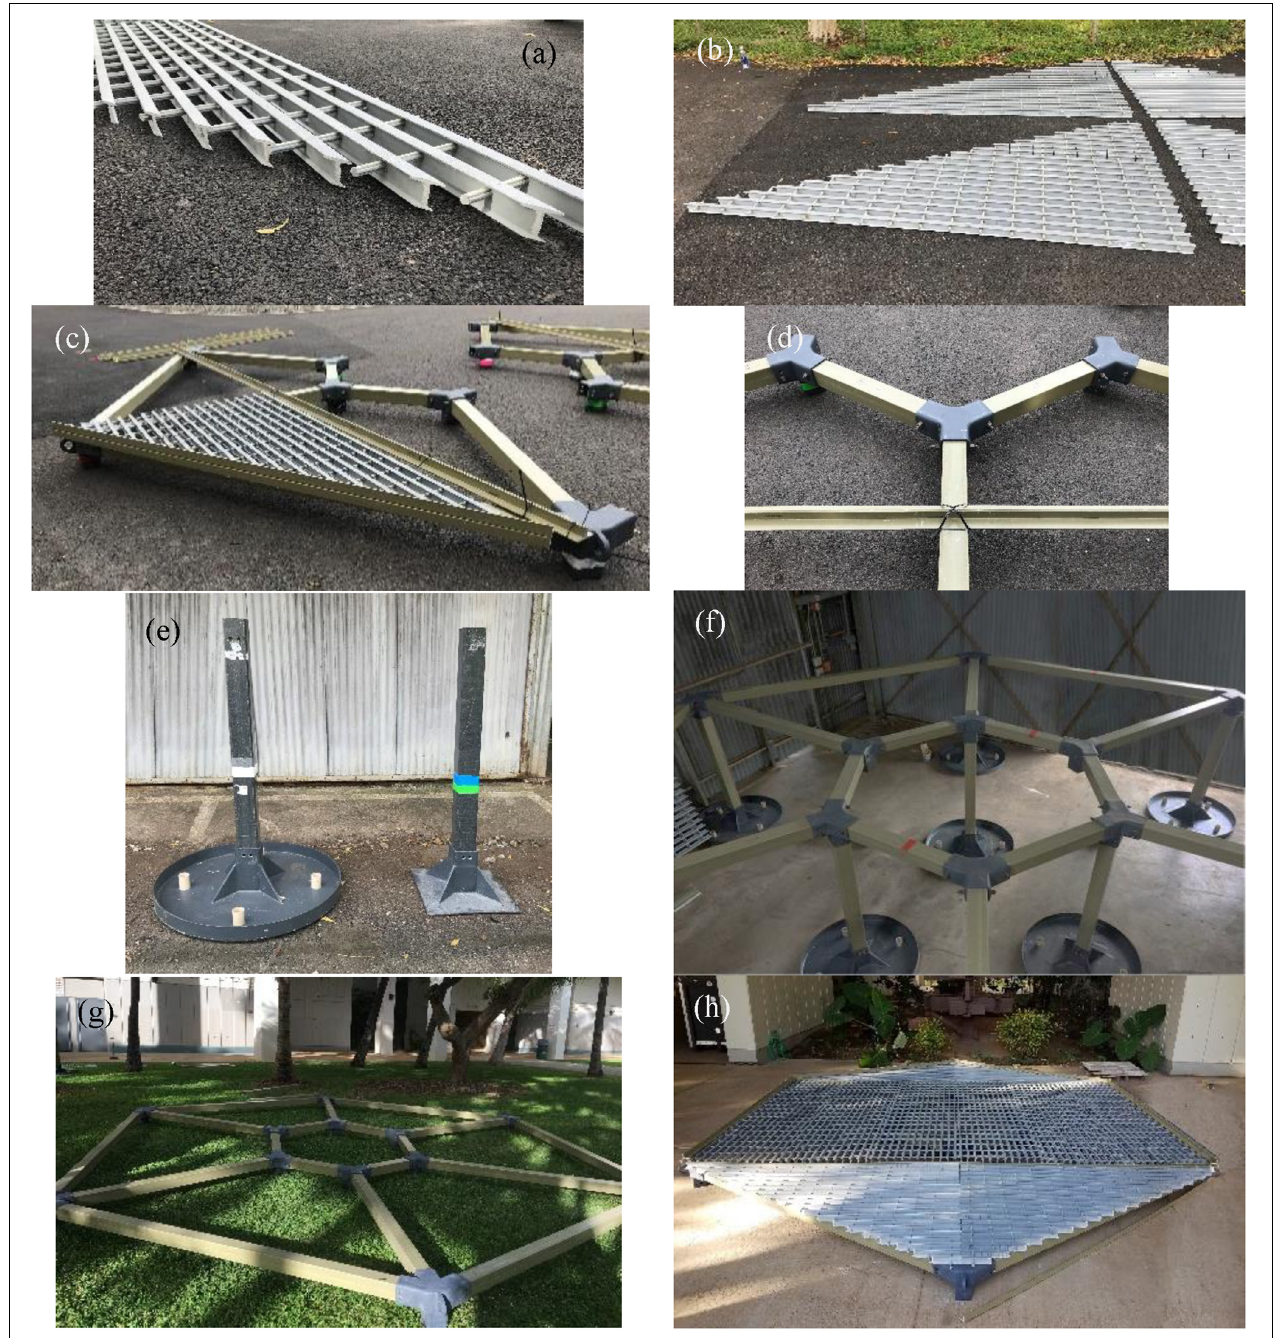
FIGURE 4 | The fabricated components of the coral nursery structure: (a) the grates with I-shaped cross section, (b) sample grating plates, (c) top face covered by the grates, (d) horizontal beams attached by the costume made joints, (e) legs marked with colorful labels for assembly, (f) assembled legs and horizontal members, (g) the hexagonal platform, and (h) top face of the platform covered with grates.